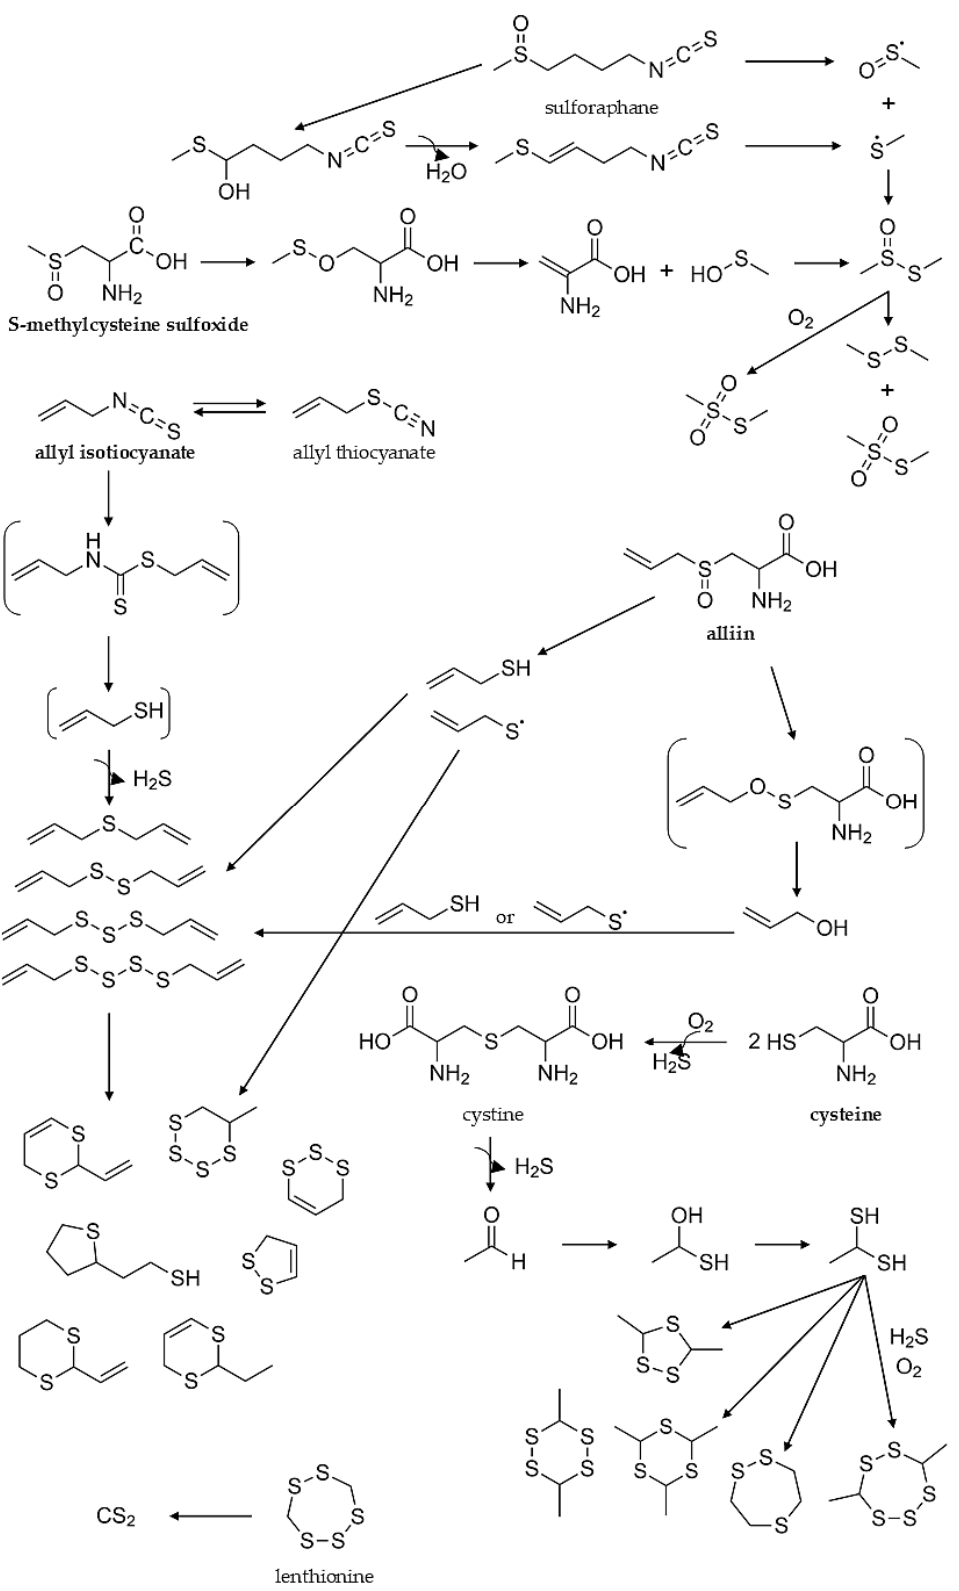
Figure 10. Thermal degradation of sulfur compounds in vegetables and mushrooms [122–128]. Despite the short treatment period with temperature, the content of GLSs in cabbage after blanching in relation to fresh vegetables decreased [134]. The loss of GLSs may